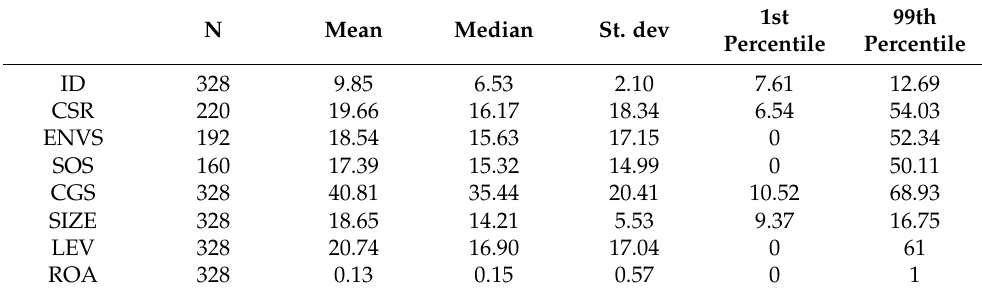
Table 1. Descriptive statistics.